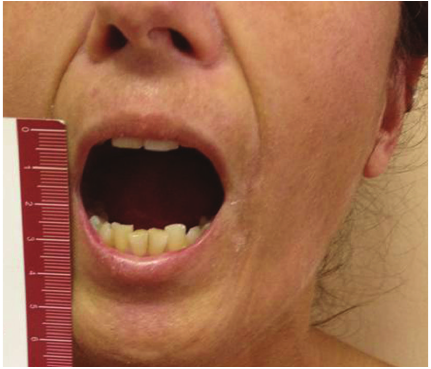
Figure 3: Follow-up at 1 year.